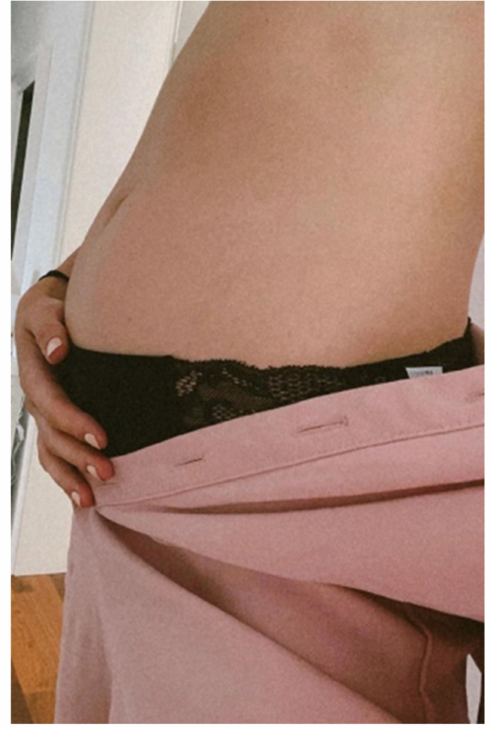
Figure 3. The endobelly: women with bowel emptying